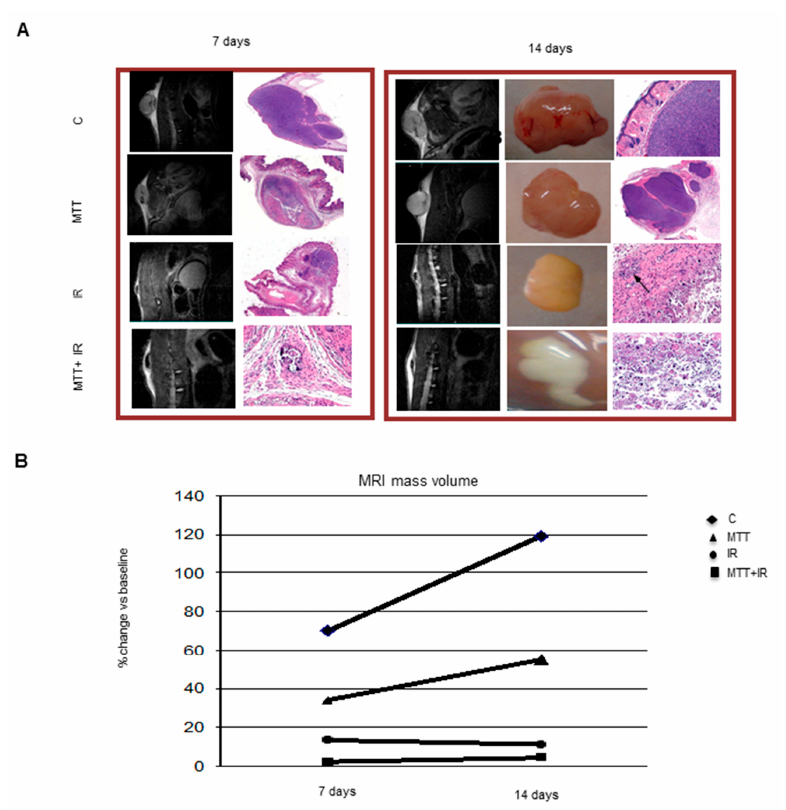
Figure 2. Morphological in vivo and ex vivo neoplastic appearance ( A ). Representative T2-W MRI images of tumor mass and histopathology staining at 7 and 14 days after treatment, with the corresponding macroscopic features. The images demonstrate an increase in tumor heterogeneity at the 7th day after treatment, consistent with a central area of hypointensity corresponding to tissue necrosis compared with the positive control. In particular, in mice treated with the combined MTT/IR treatment, there is evidence of a large fibrotic outline surrounding necrosis within the tumor mass. The MRI images are also consistent with the macroscopic specimens. In mice receiving the combined MTT/IR therapy, macroscopically, the tumor is replaced by a large area of fibrotic tissue at 14 days. At 14 days, slices confirm necrotic areas in the samples treated with IR and IR/MTT. The black arrows in the samples correspond to the IR treatment and show the presence of some neoplastic cellular foci .